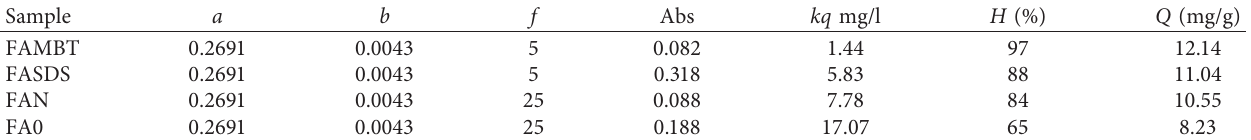
Table 4: Cd 2+ adsorption parameters by FA0, FAN, and modified FAN particles.